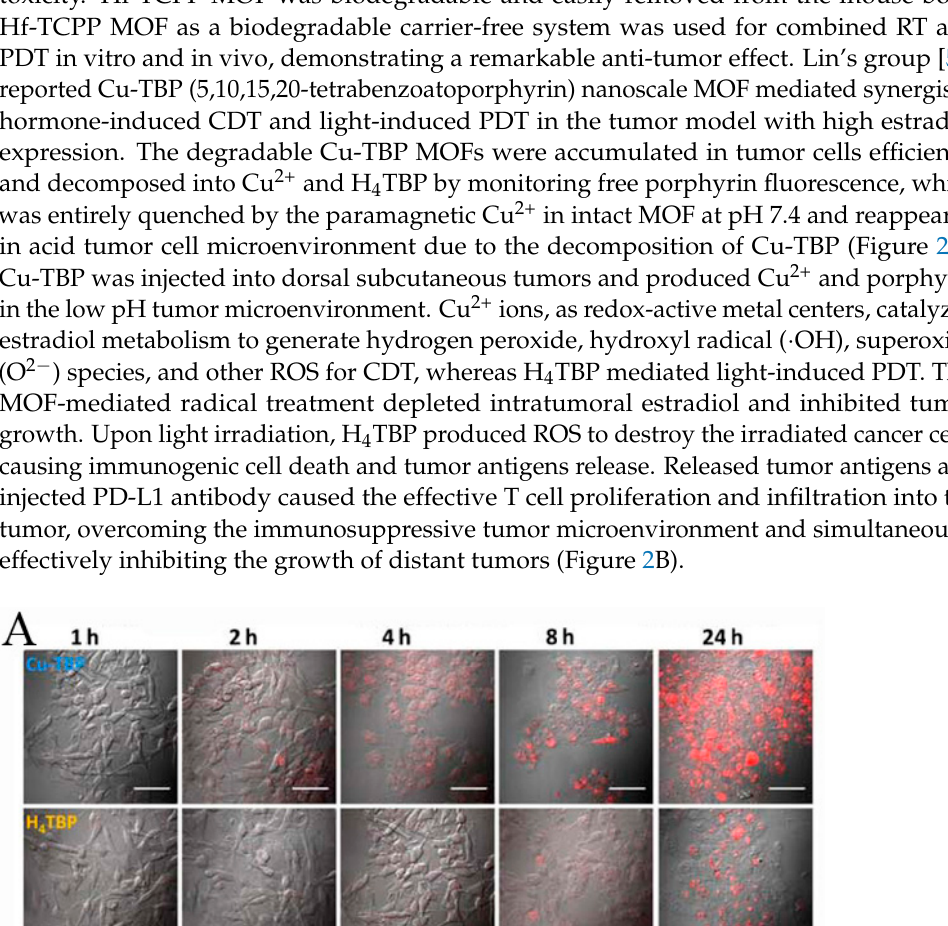
Figure 3. Mn ‐ Zr MOF generates abundant ROS of ∙ OH and a high microwave thermal conversion efficiency after exposure to MW irradiation, resulting in efficiently inhibiting the cancerous cell growth through the synergic effect of MDT and MTT. Reprinted with permission from Ref. [55]. Copyright 2018, American Chemical Society.